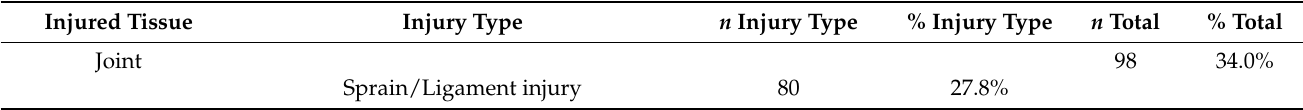
Table 2. Injured tissues and injury